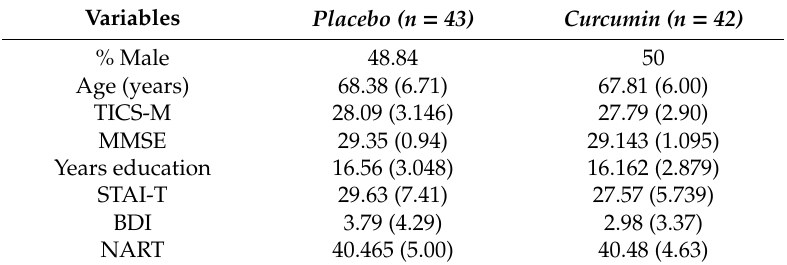
Table 1. Baseline Group Demographics. Except for gender, numbers are mean with standard deviation (SD) in